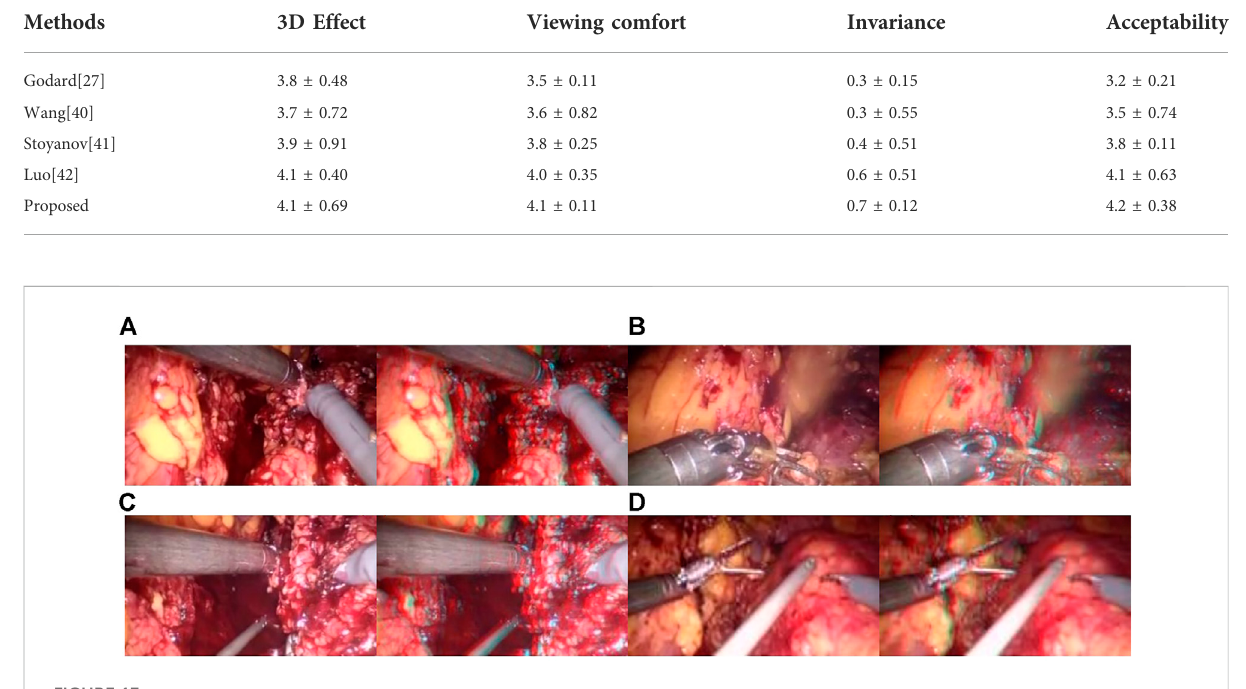
FIGURE 13 Redandblue3Ddisplayimages.Theleftimageineachsub-imageistheoriginalview,andtherightimageisthechromatic3Ddisplayimage. (A – D) are randomly selected from the experimental results.